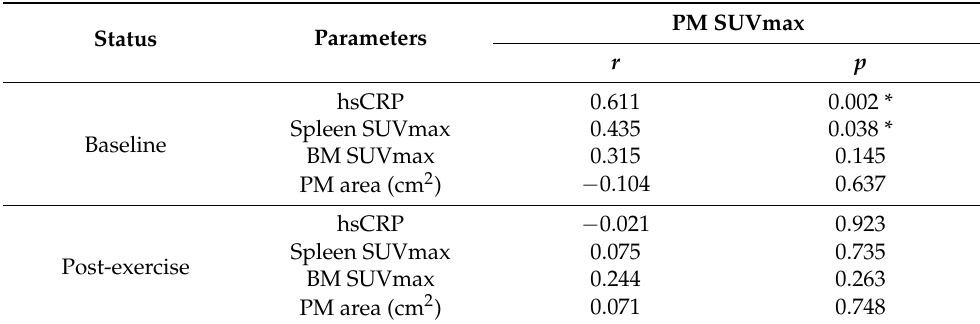
Table 3. Correlations between PM SUVmax, PM area, and systemic inflammatory surrogate markers at baseline and